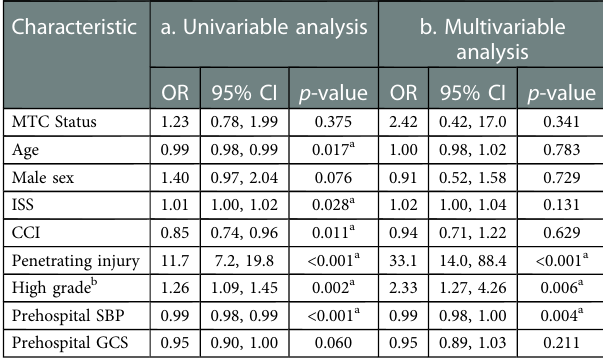
TABLE 2 Odds ratio of requiring laparotomy following liver trauma according to patient and injury characteristics. Characteristic a. Univariable